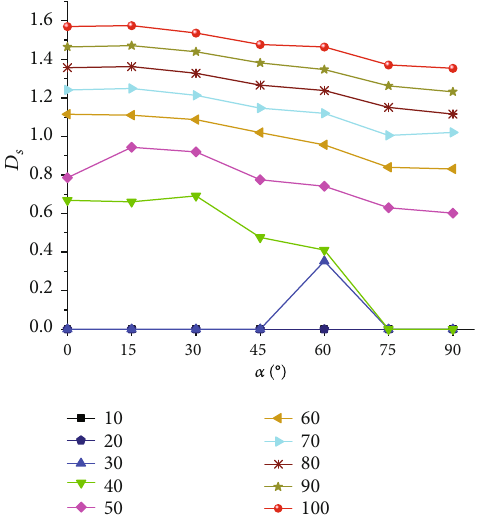
Figure 18: Relationship between position angle and fractal dimension under di ff erent stress